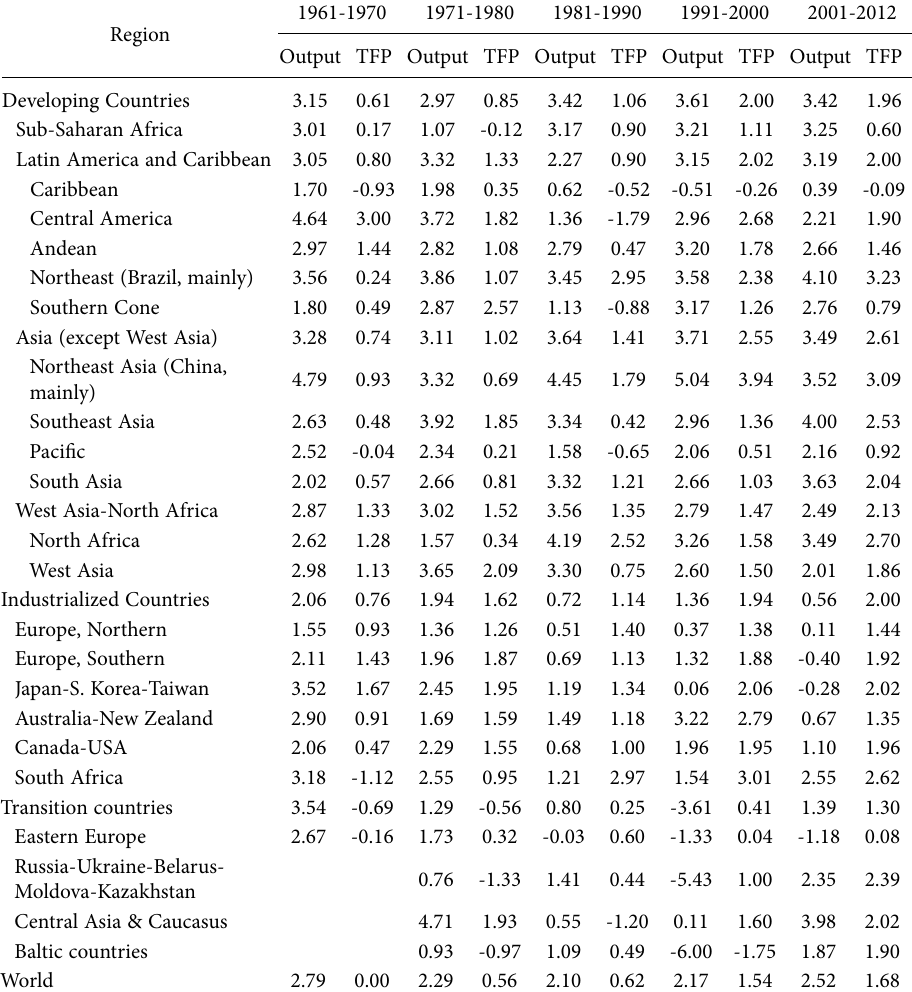
Table 4. Agricultural Output and Total Factor Productivity Growth in Global Regions.